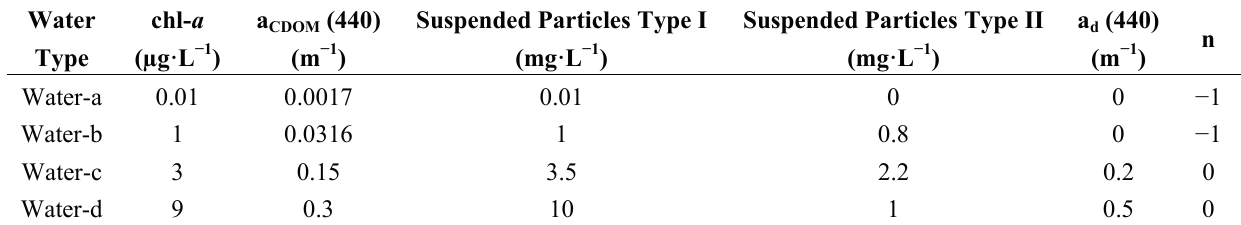
Table 2. Water characteristics of the four different types of water used to simulate surface reflectance in shallow